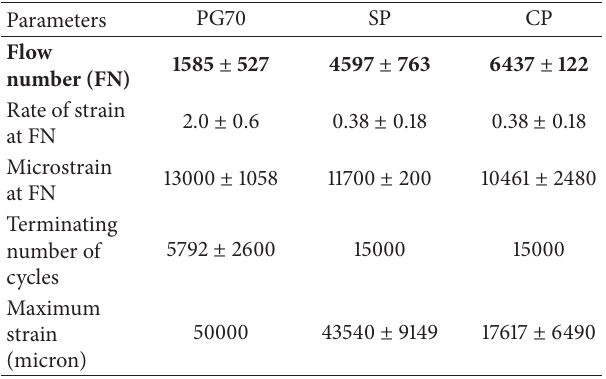
Table 5: Flow number test data.